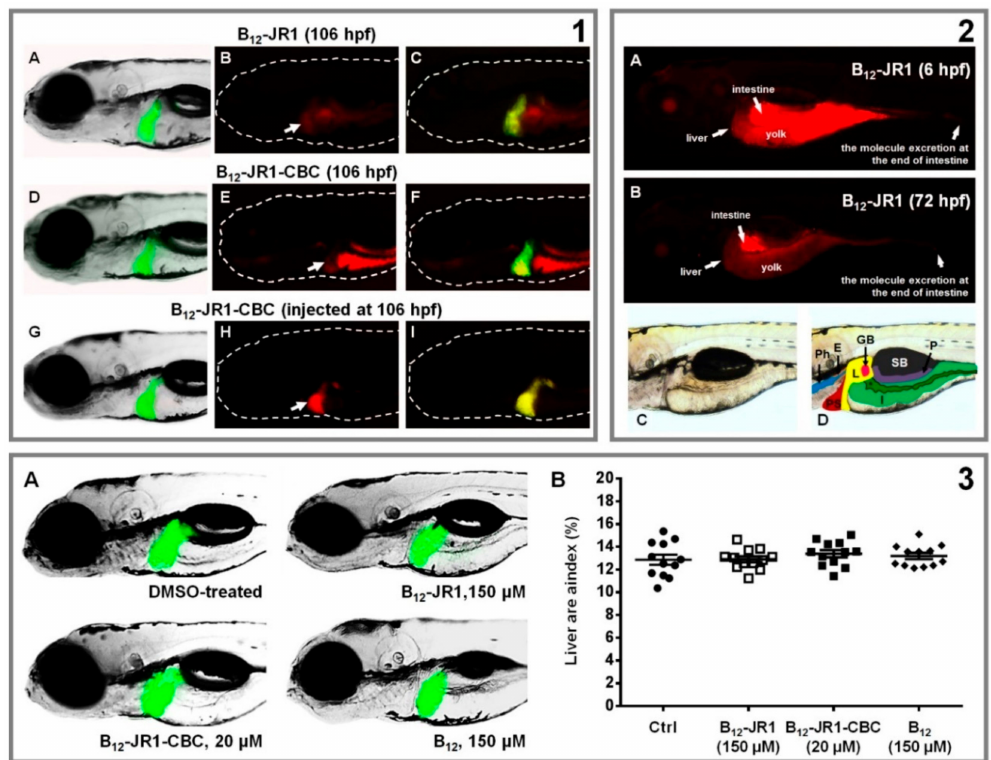
Figure 7. Bio-distribution and toxicity evaluation of B 12 - JR1 and B 12 - JR1-CBC in the 120-hpf old transgenic Tg ( fabp10 :EGFP) zebrafish embryo with fluorescently labelled liver. Panel 1 (top left). Top: accumulation of B 12 - JR1 (150 µ M) in the liver applied at 106 hpf in the embryo water. (A) Embryo imaged by a fluorescent microscope with a filter enabling only EGFP-labelled liver visualization. (B) Embryo imaged with a filter enabling B 12 - JR1 visualization, but not EGFP-labelled liver. (C) Merged images A and B. Middle: accumulation of B 12 - JR1-CBC (20 µ M) in the liver applied at 106 hpf in the embryo water. (D) Embryo imaged upon a filter enabling only EGFP-labelled liver visualization. (E) Embryo imaged with a filter enabling only B 12 - JR1 visualization, and ( F ) merged Tg ( fabp10 :EGFP) and B 12 - JR1-CBC fluorescent signals in the same embryo. Bottom: an accumulation of B 12 - JR1-CBC (47.8 µ g per an embryo, corresponding to 20 µ M dose) in the liver microinjected (parenteral use) into embryo’s circulation at 106 hpf. Arrows in the panel 1 indicate the liver position within embryos body. Panel 2 (top right): distribution of B 12 - JR1 (150 µ M) within the 120-hpf old embryos when applied at 6 hpf (the liver-free stage, A) or 72 hpf (the stage with functional liver, B). Lateral views (C and D) of the 120-hpf embryo with an overlay. Overlay outlines the pharynx (Ph), esophagus (E), liver (L), gallbladder (G), pancreas (P), swimmbladder (SB), and intestine (I). * marks intestinal lumen. Panel 3 (bottom). Hepatotoxicity evaluation in the transgenic Tg ( fabp10 :EGFP) zebrafish embryos with EGFP-labelled liver after the embryos exposure to the tested compounds in a period from 72–120 hpf (A). The liver area index was assessed in 120-h old zebrafish embryos (B) and indicated no changes in the treated groups compared to the DMSO-treated (control) one ( n =